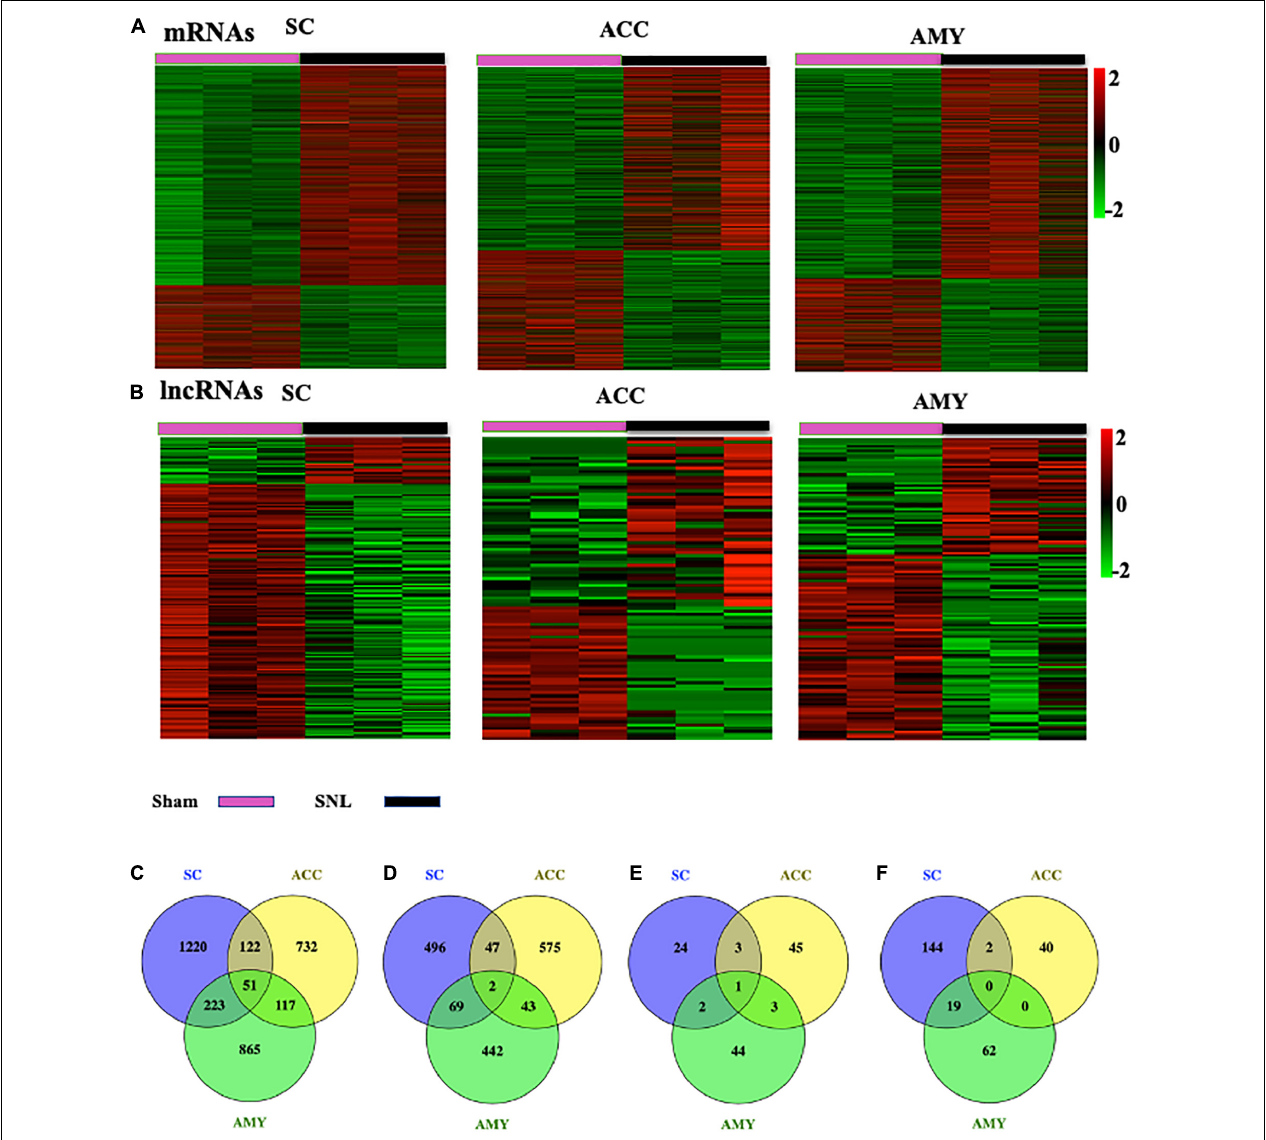
FIGURE 2 | Differentially expressed mRNAs and lncRNAs in the SC, ACC, and AMY after nerve injury. (A,B) Heatmaps of significantly differentially expressed mRNAs (A) and lncRNAs (B) in the SC, ACC, and AMY from mice on day 7 post-SNL or -sham surgery. n = 9 mice/group. (C,D) Venn diagrams indicate the